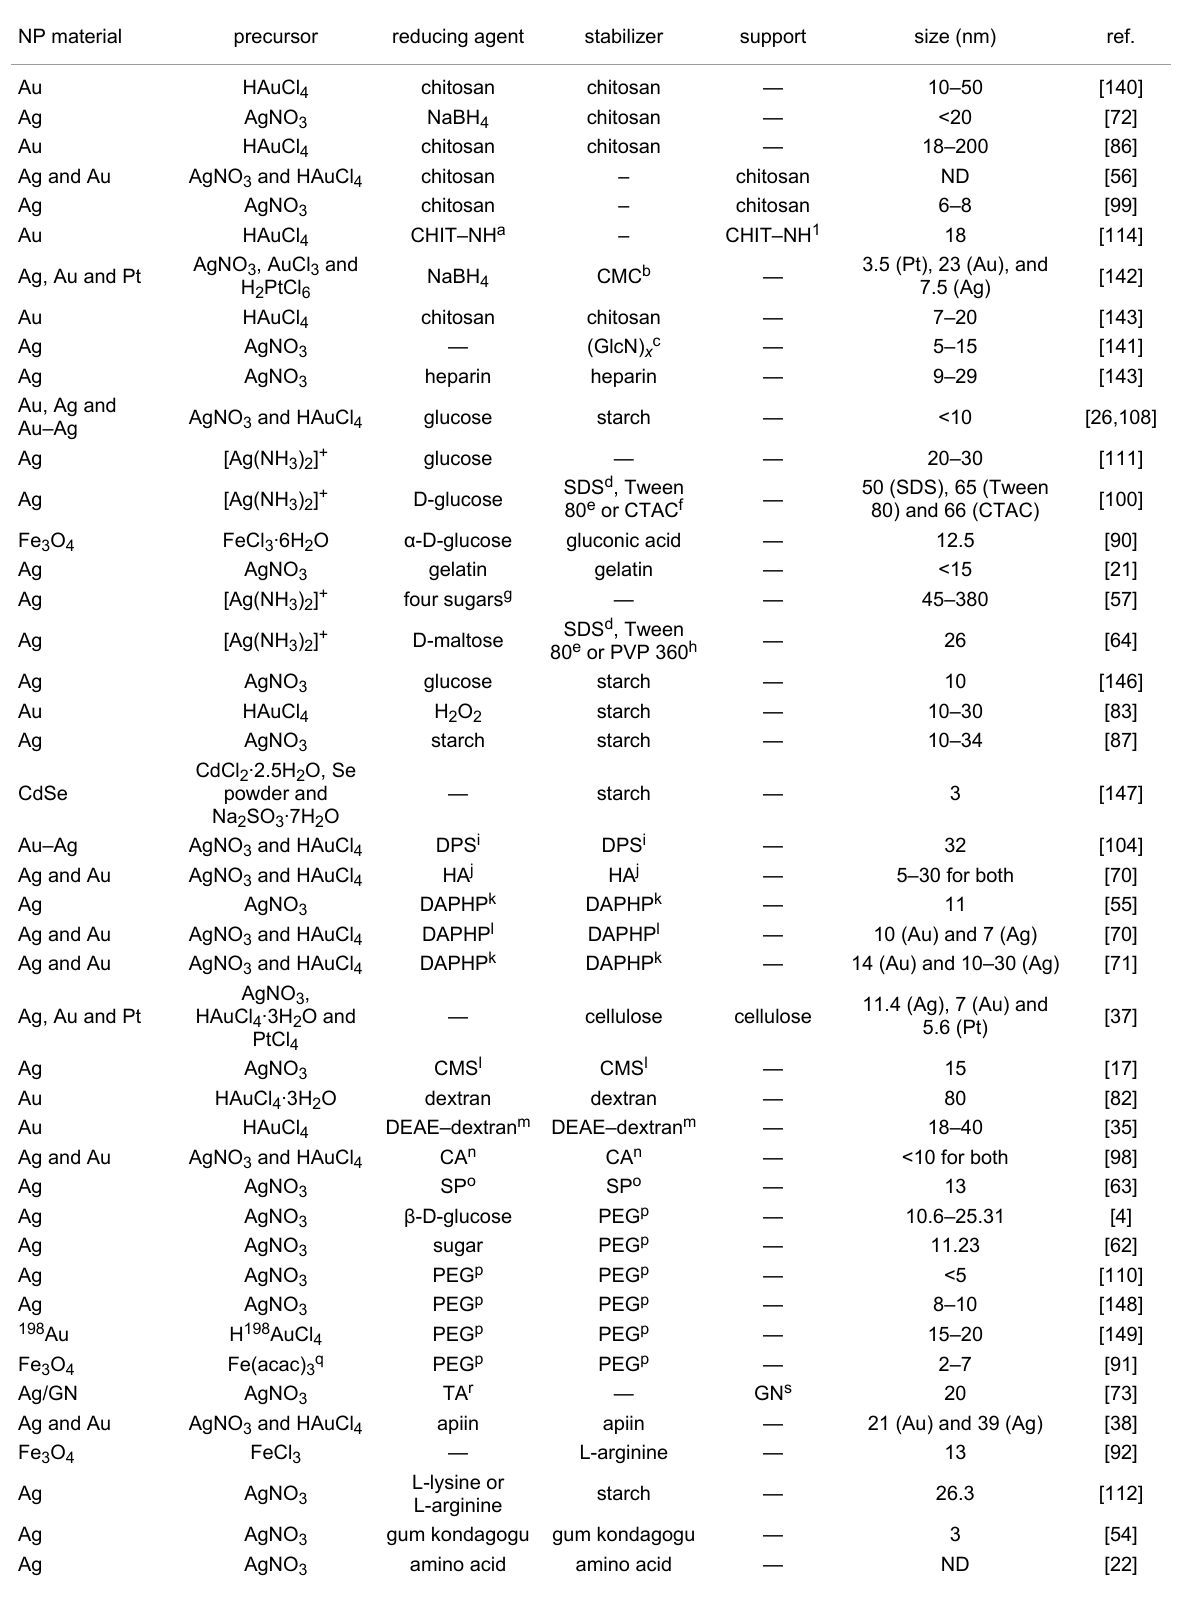
Table 2: Summary of synthesized NPs with different green